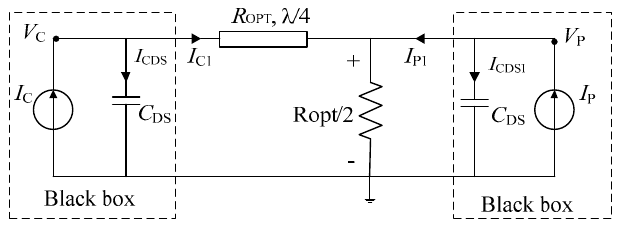
Figure 1. Conventional Doherty power amplifier (DPA) topology with drain-to-source capacitance ( C DS ).